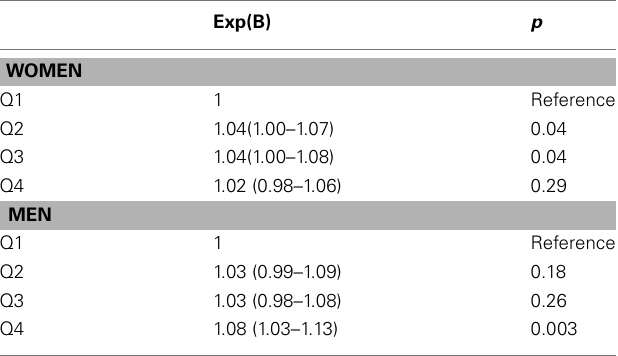
Table 3 |Analysis of influence of season of birth (Q1 to Q4) on hip fracture rates, assessed by multiple linear regression after ln transformation.